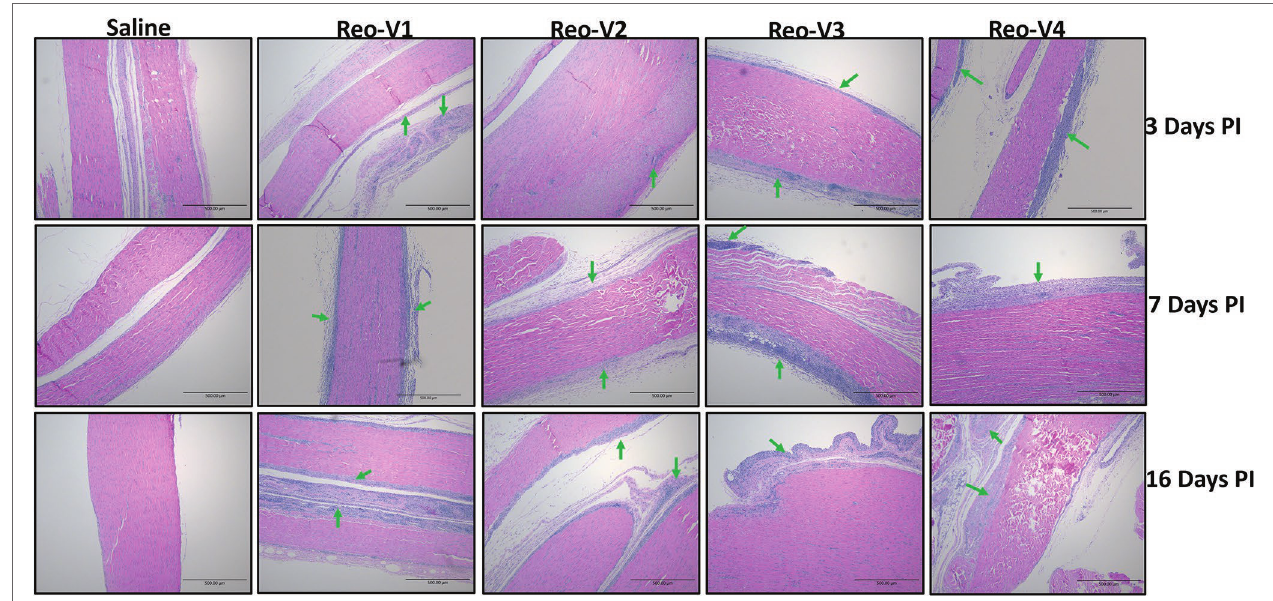
FIGURE 3 | Histopathology of tendon tissues of birds infected with arthrotropic ARV representing different genotype cluster groups [i.e., Reo-V1 (Cluster-5), Reo-V2 (Cluster-4), Reo-V3 (Cluster-2), or Reo-V4 (Cluster-6)] at different times PI (post-infection). Lymphocyte infiltrations are indicated by green arrows.